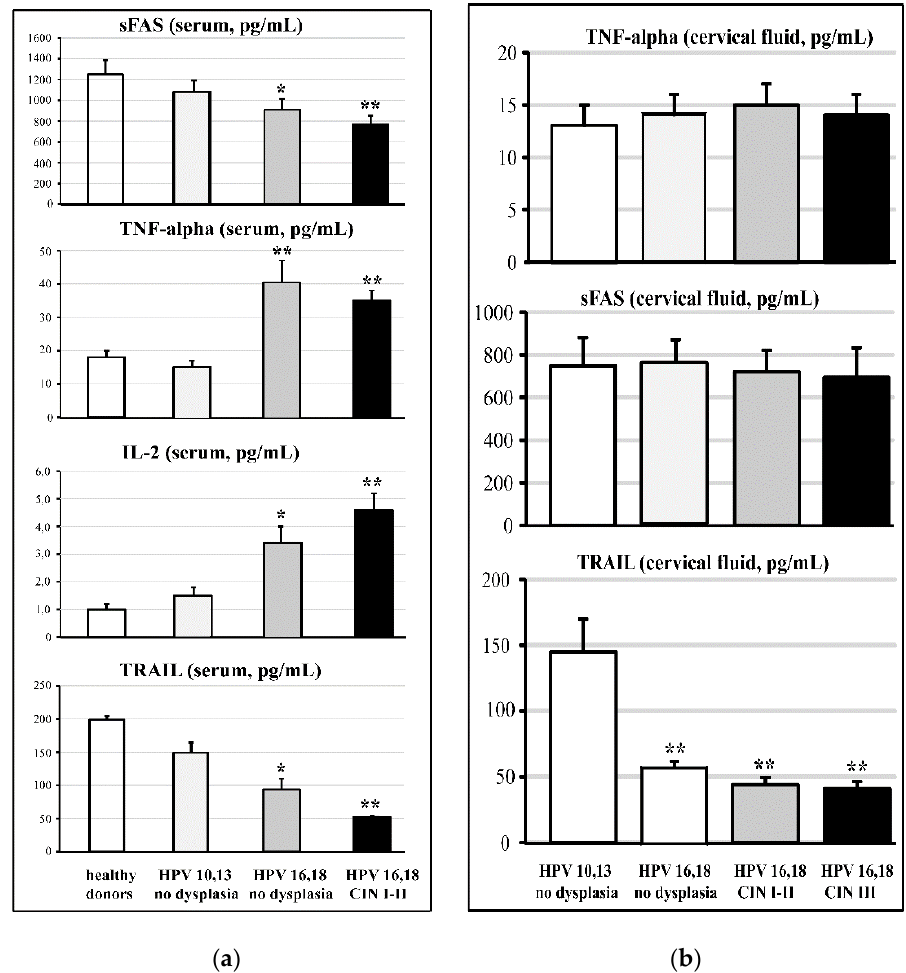
Figure 3. Serum ( a ) and cervical ( b ) ligands of TNF-alpha-induced apoptosis in females at different stages of HPV-associated carcinogenesis. Sample size of groups: HPV 10/13, n = 42; HPV 16/18 and healthy, n = 152; HPV 16/18 CIN I and CIN II, n = 75; healthy donors, n = 15. * p < 0.05 vs. healthy donors and low oncogenic HPV infection; ** p < 0.01 vs. healthy donors and low oncogenic HPV infection.